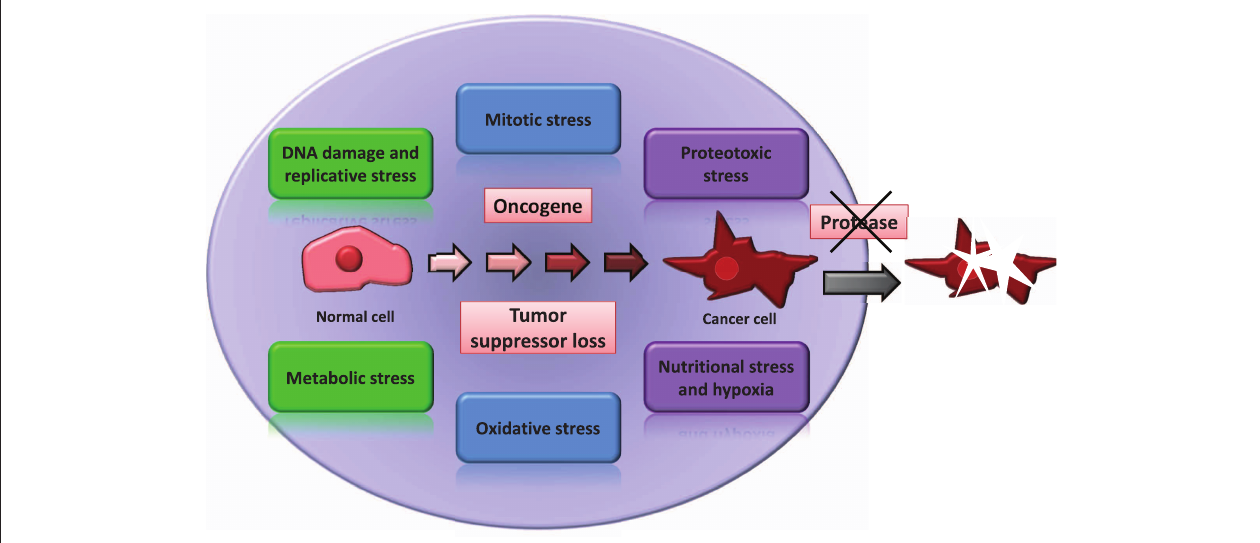
Figure 1 | Protease addiction in cancer. Cancer cells are under different forms of cellular stress as a side effect of the transformed phenotype. We hypothesize that for most cases of cancer, it will be possible to find one or more proteases specifically required for the maintenance of cancer cell